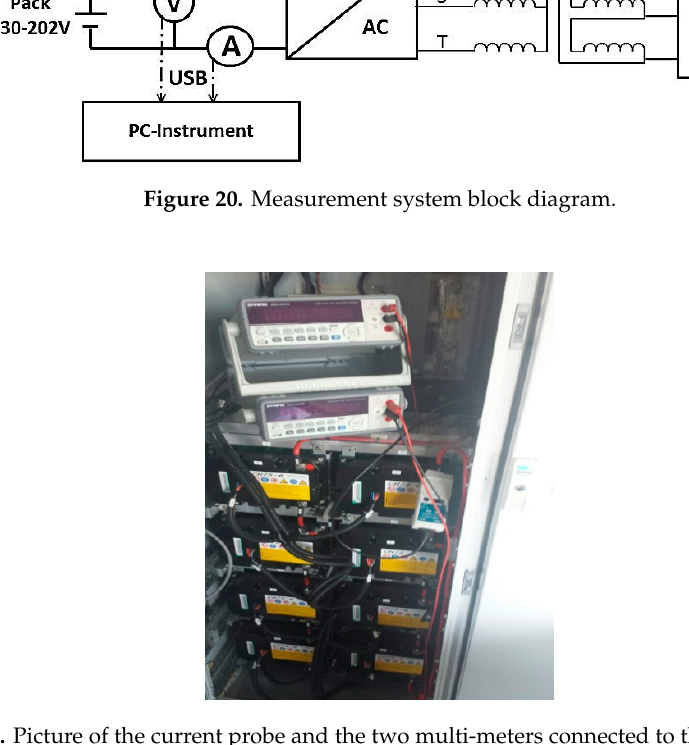
Figure 21. Picture of the current probe and the two multi-meters connected to the battery series.